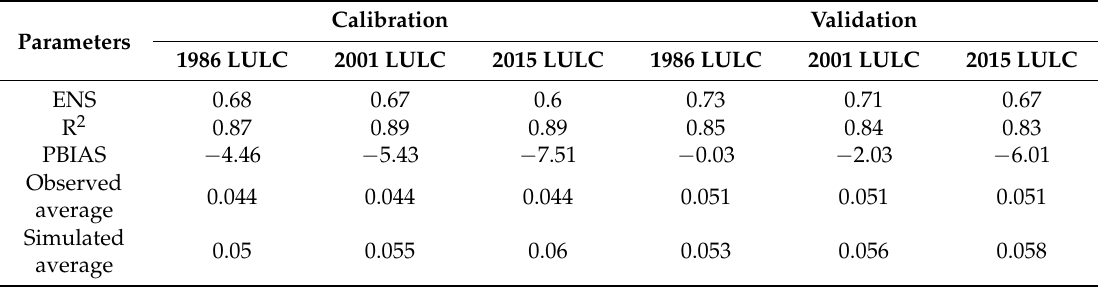
Table 7. Statistical values of ENS, R 2 and PBIAS during model calibration and validation under varying LULC during sediment yield modeling.